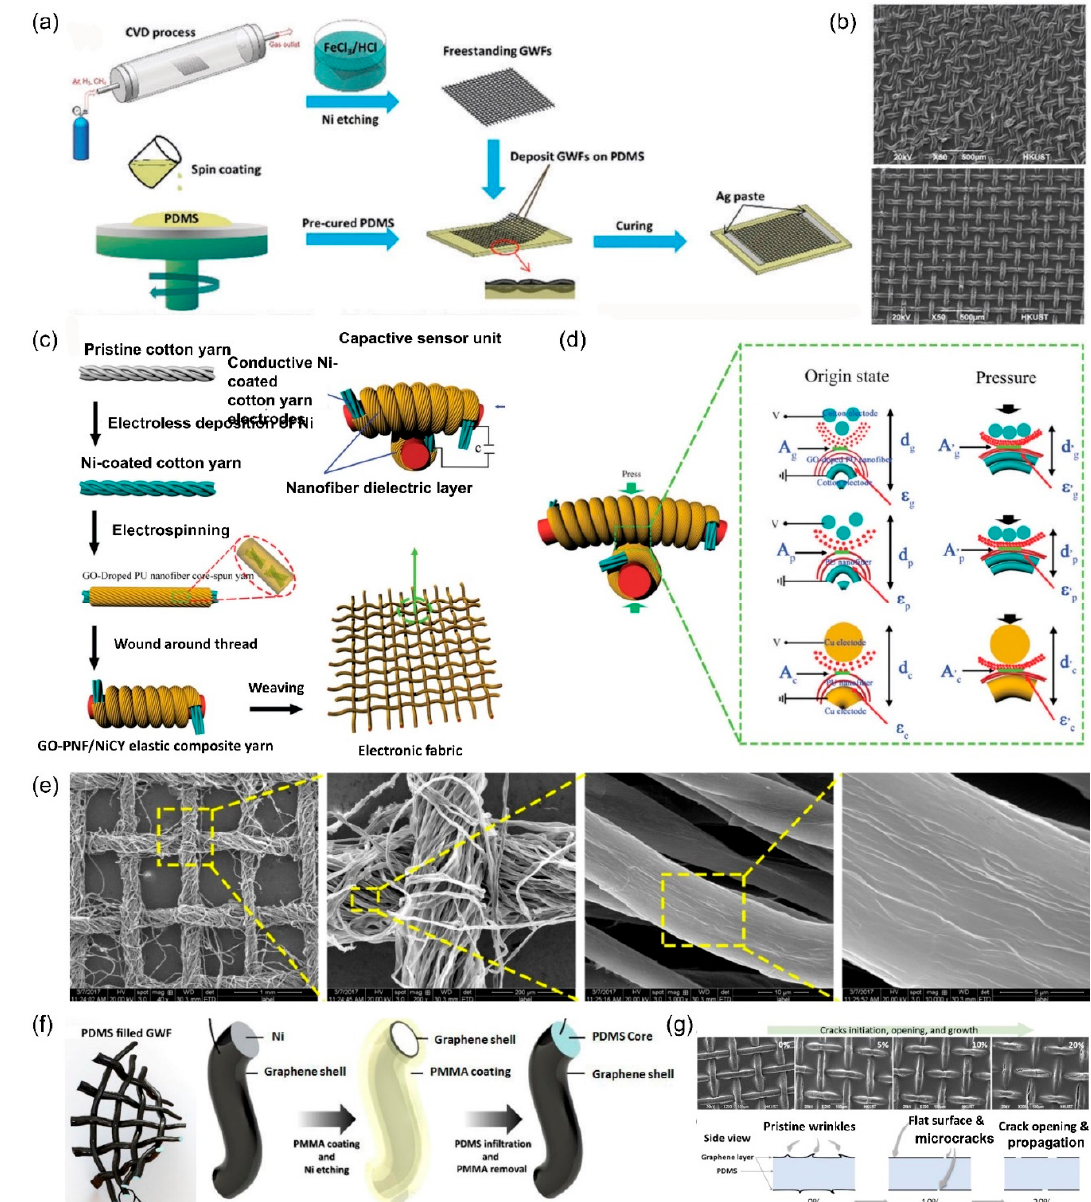
Figure 11 . ( a ) Fabrication processes of PDMS − and graphene − woven fabric; ( b ) SEM images of gra- Figure 11. ( a ) Fabrication processes of PDMS- and graphene-woven fabric; ( b ) SEM images of phene and PDMS composites including different type of graphene − woven fabrics; Reprinted with graphene and PDMS composites including different type of graphene-woven fabrics; Reprinted with permission from Ref. [92]. 2017, Royal Society of Chemistry. ( c ) schematic of the fabrication of the capacitive sensor in an electronic fabric; ( d ) sensing mechanisms of the flexible sensor during the pressing process; Reprinted with permission from Ref. [94]. 2018, Royal Society of Chemistry. ( e ) SEM micrographics of rGO-woven fabrics under different magnifications Reprinted with permission from Ref. [95]. 2017, American Chemical Society. ( f ) schematic flowchart of the fabrication procedure of an PDMS-filled graphene-woven fabric; and ( g ) SEM images showing crack evolution in composite sensor with increasing strain, accounting for the sensing mechanisms. Reprinted with permission from Ref. [96]. 2019, American Chemical